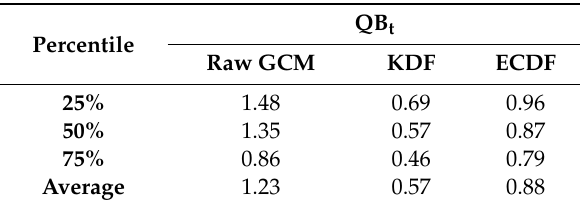
Figure 6. Monthly observed and QM-downscaled (bias–corrected with ECDF and KDF) precipitation at Nouroozloo station for the calibration period 1977 to 1996. Table 5. Precipitation quantile bias (QB t ) as a function of the percentile obtained with the raw GCM, KDF and ECDF-QM